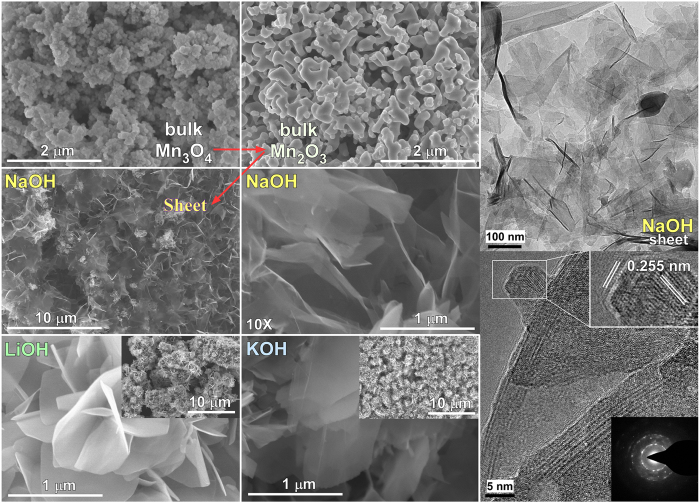
SEM images of Mn3O4, Mn2O3 and the synthesized materials in 1.0 M NaOH, LiOH, and KOH solutions.TEM and HRTEM images of the nanosheets synthesized in 1.0 M NaOH solution. The inset shows the SAED pattern of the nanosheets.